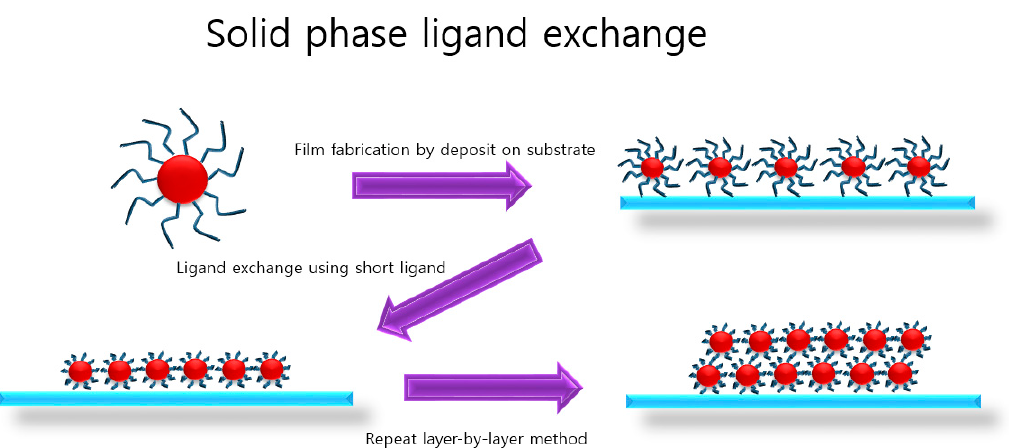
Figure 1. Schematic of solid-state ligand exchange and film fabrication. Initially, colloidal quantum dots (CQDs) were deposited on the substrate, and then ligand-exchanged using short organic ligands. CQD film fabrication is completed by repeating this